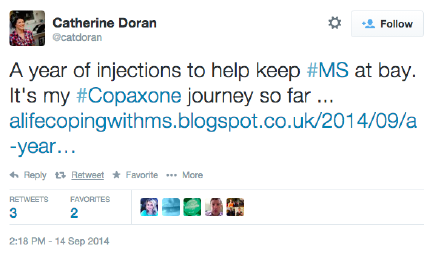
Figure 2. Example tweet from company-specific analysis.